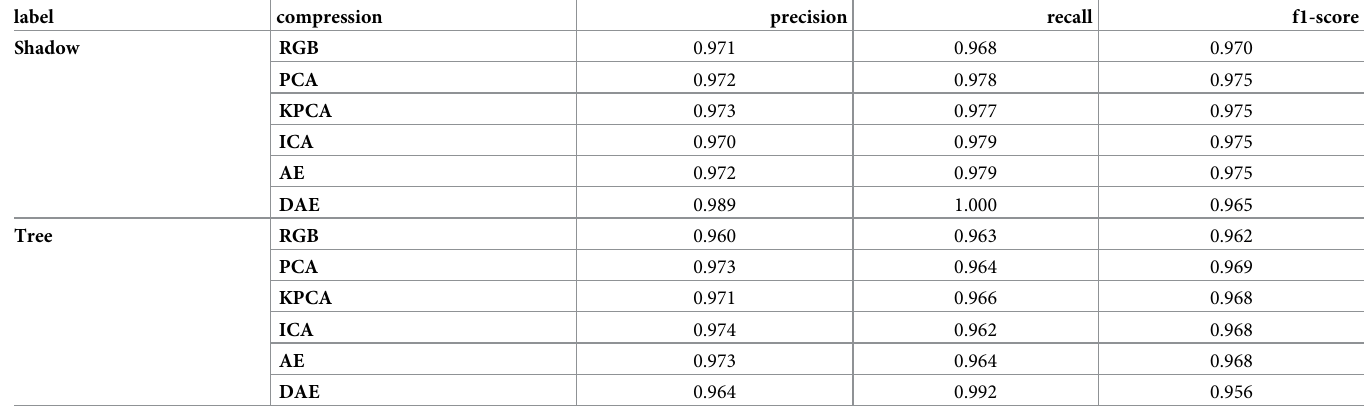
Table 6. Top classification scores Forest, HSI, compression rate = 95%.